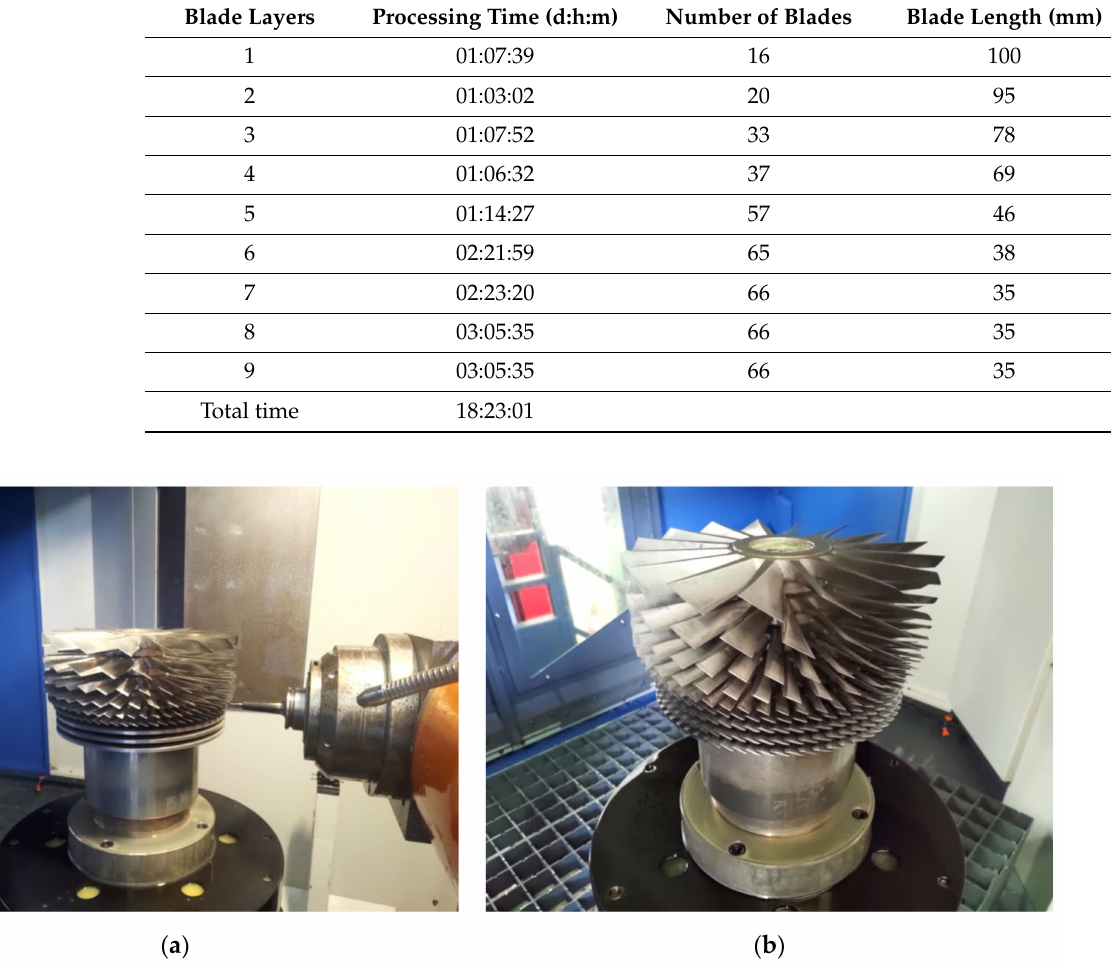
Table 2. Rotor machining time.